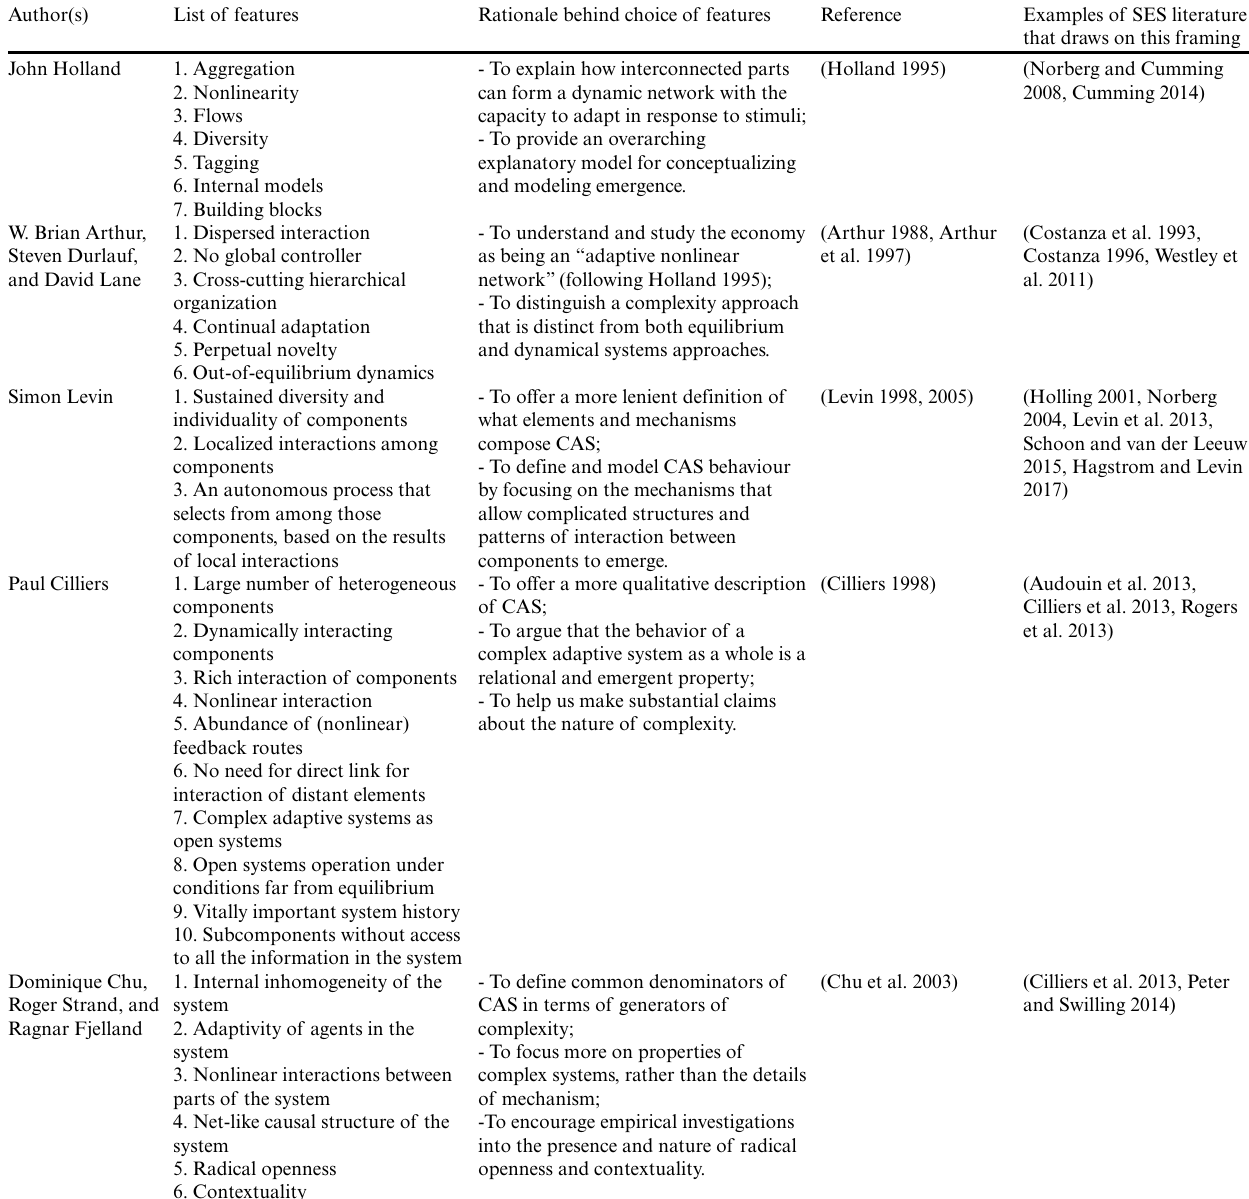
Table 1 . Overview of prominent authors’ classifications of complex adaptive systems (CAS) features, the characteristics they suggest for identifying CAS, and how these respective classifications have influenced social-ecological systems (SES)